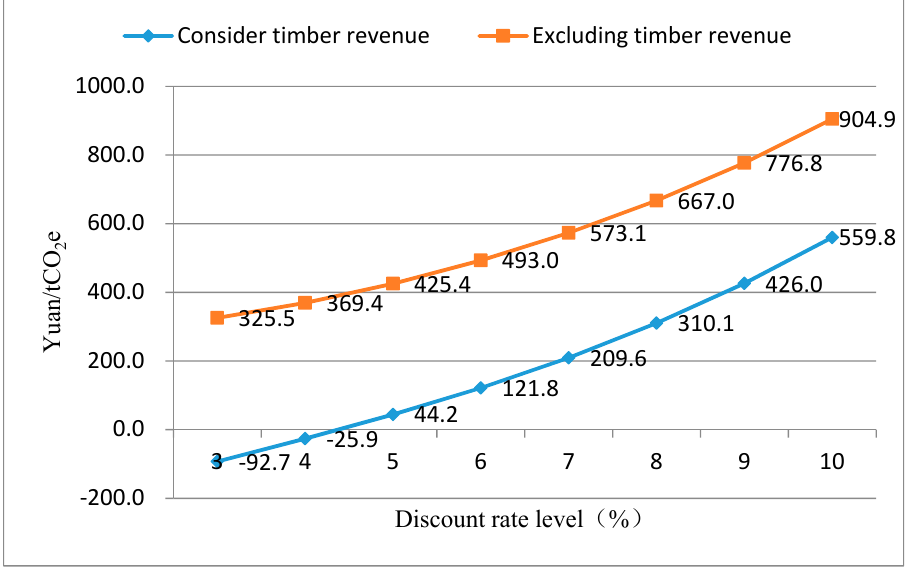
Figure 4. The carbon sequestration cost under different discount rate.